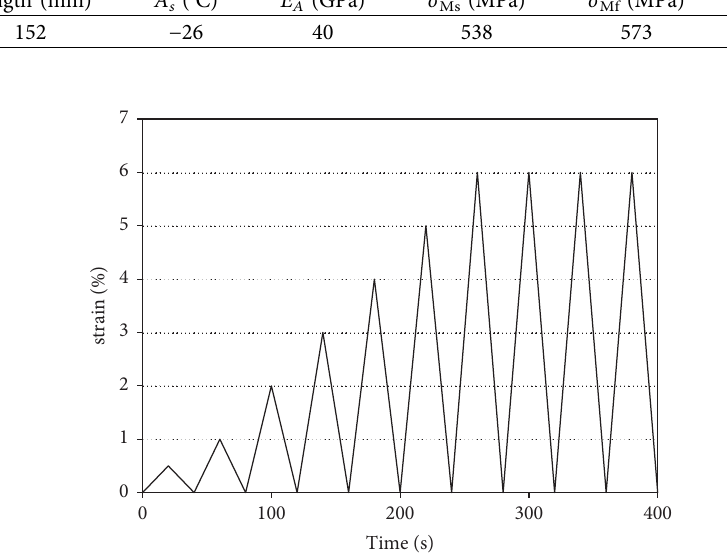
Figure 6: Cyclic loading applied to the SMA.